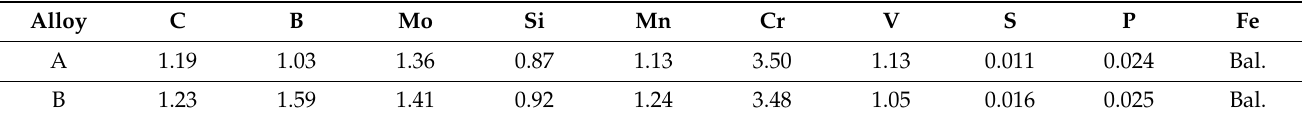
Table 1. The chemical constituent of the testing alloy steel